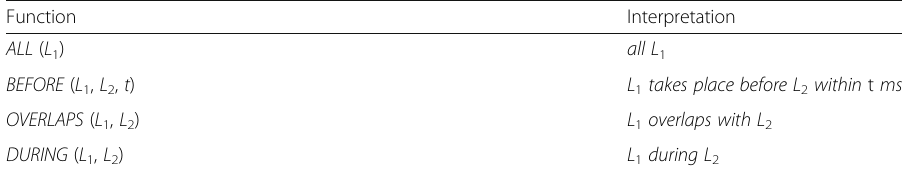
Table 2 Function list for condition setting